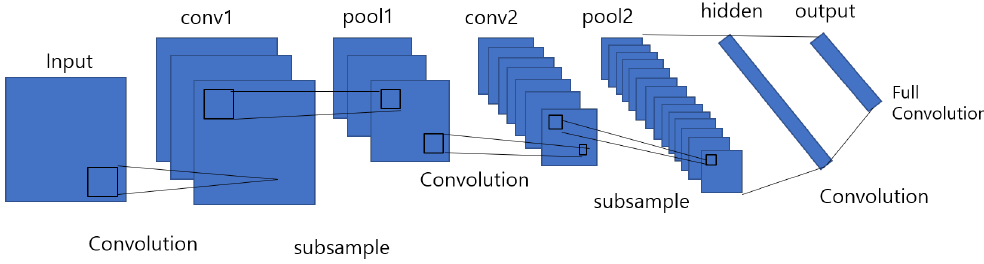
Figure 2. A sample of 7-layer CNN model classified digits for digitized pixel greyscale input images in image